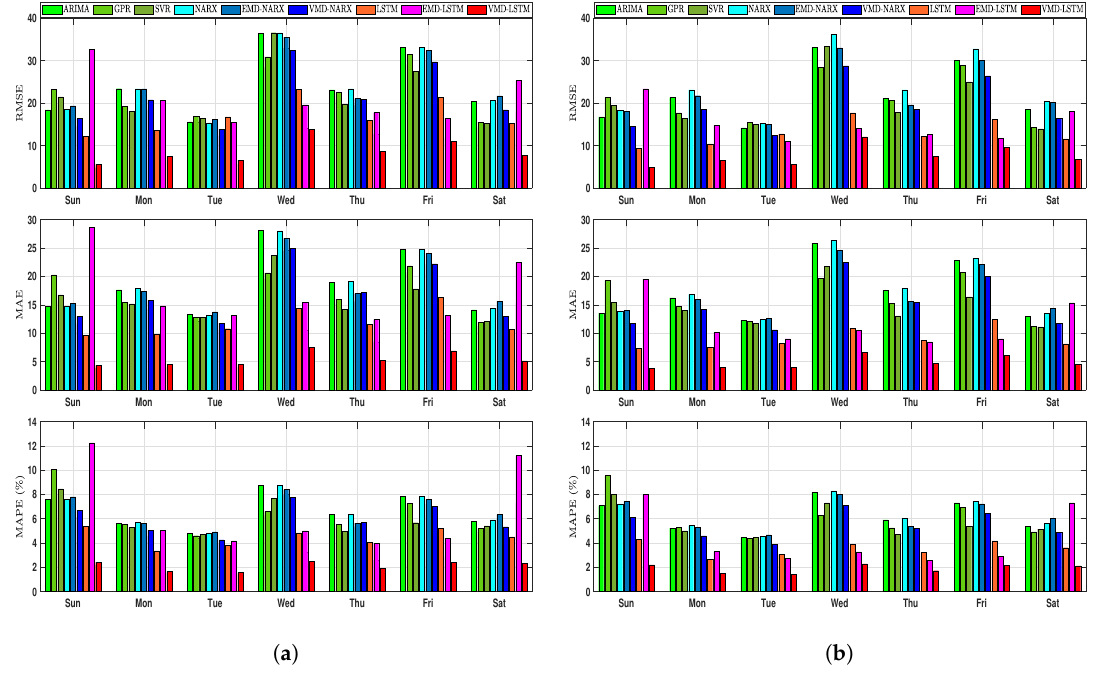
Figure 8. Benchmarks of different models. ( a ) One-month AMI data; ( b ) Three-month AMI data. The MAPE of VMD-LSTM was around 2%. In the weekly comparison, the least error occurred on Tuesday: RMSE of 6.49 kWh, MAE of 3.98 kWh, and MAPE of 1.48%. This was because the